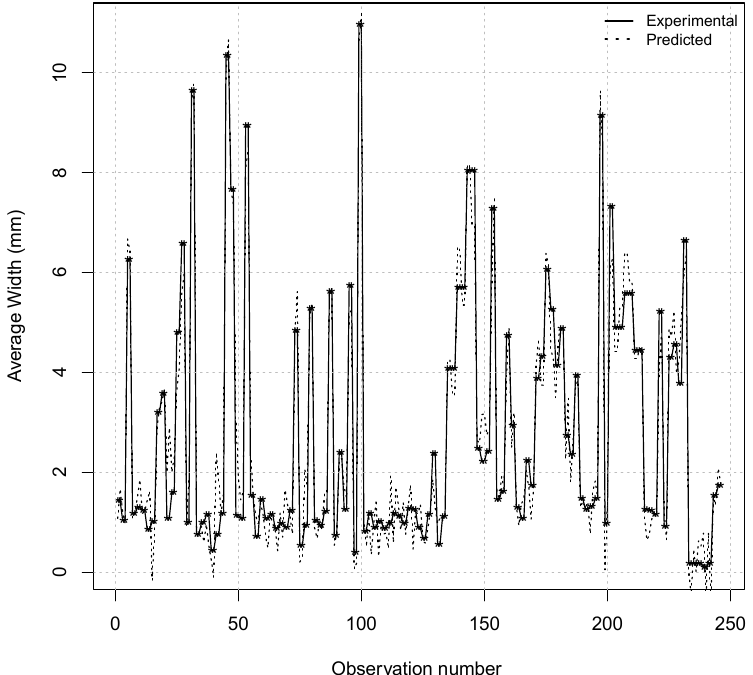
Figure 8. Comparison between the values of the Average Width of the spots forming the centerline of segregation observed experimentally and predicted by the model MARS from 245 actual